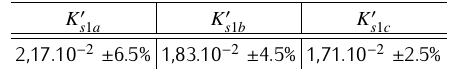
Table 2. Calibration coefficient D ′ s 1 i (nstr/V) of a gauge i to internal deformation (solid